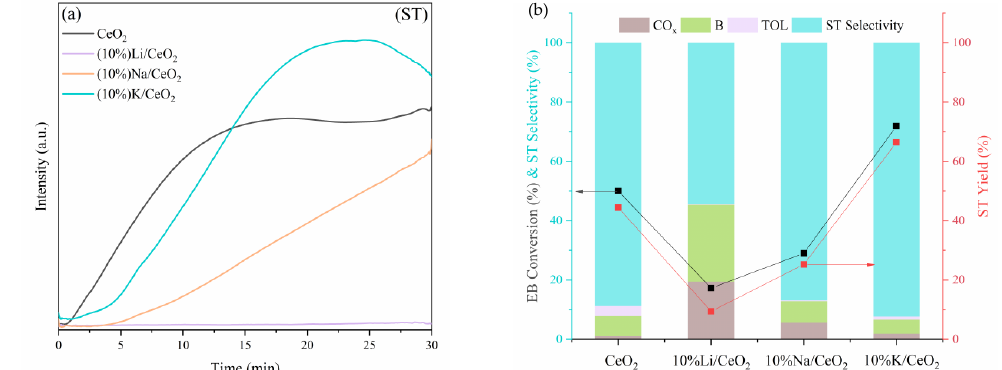
Figure 3. Catalytic performance of alkali metal Li/Na/K modified CeO 2 . ( a ) styrene (ST) mass spectra of 10%X/CeO 2 ; ( b ) product distribution of 10%X/CeO 2 at 500 ◦ C (X = Li, Na, K). Experimental conditions: temperature rise rate 10 ◦ C/min, T EB = 25 ◦ C, flow rate 25 mL/min, atmosphere Ar, catalyst dosage 500 mg, space velocity = 7.5 h − 1 .